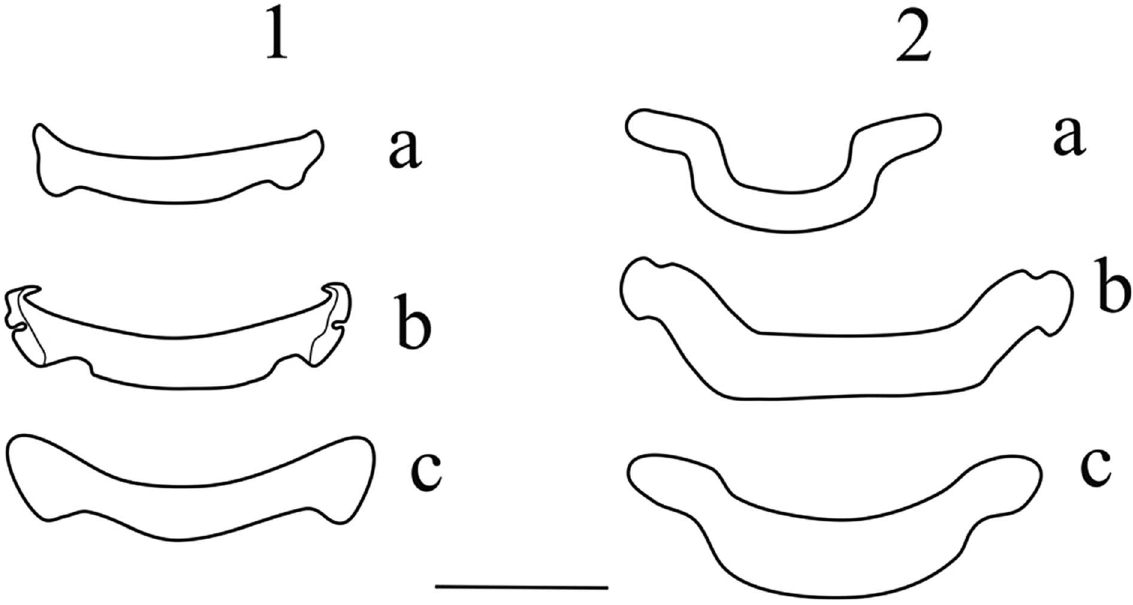
Figure 5. Comparison of the dorsal bar shapes of Synodontella species from the Sanaga River (1) and from the Boumba River (2). 1.a, Synodontella melanoptera ; 1.b, Synodontella apertipenis ; 1.c, Synodontella sanagaensis ; 2.a, Synodontella angustupenis n. sp.; 2.b, Synodontella simplex n. sp.; 2.c, Synodontella longipenis n. sp. Scale bar = 20 l m.